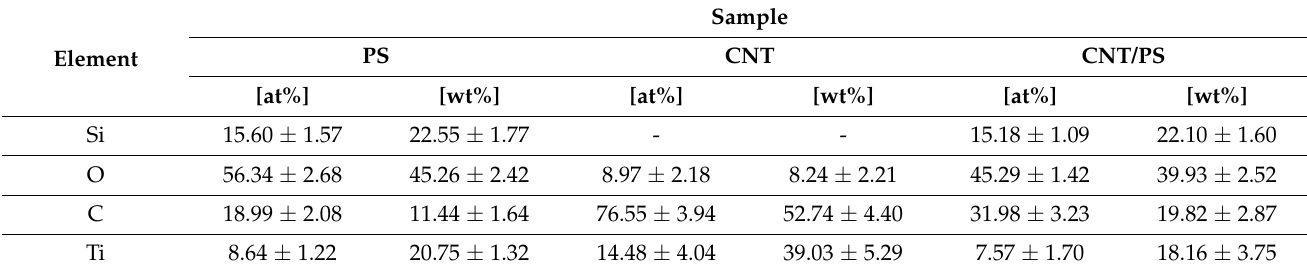
Figure 1. SEM images of PS, CNT and CNT/PS coatings on titanium surface. Table 1. EDS analysis results for the obtained